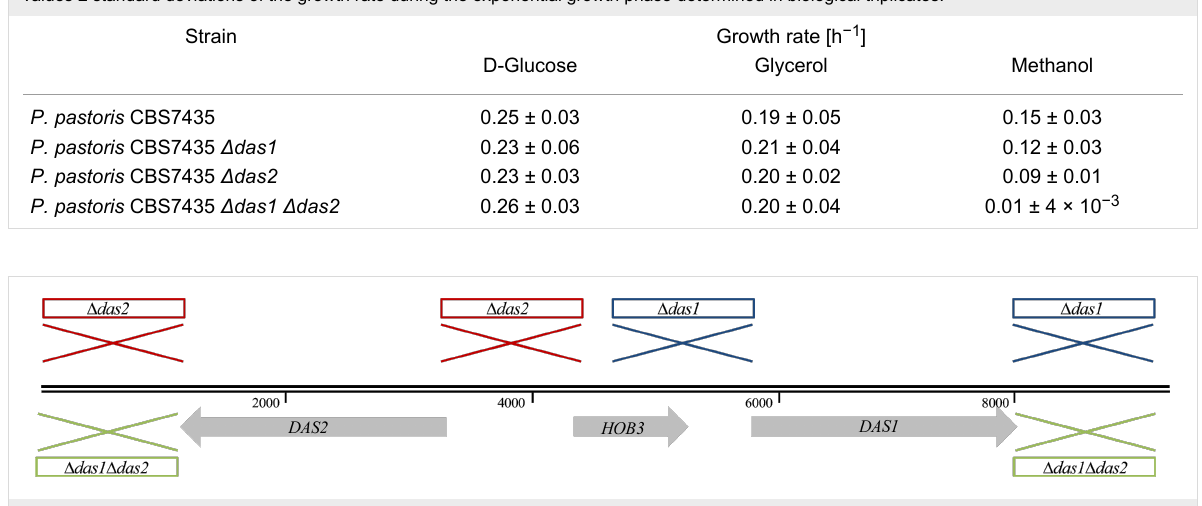
Table 1: Specific growth rates of P. pastoris CBS7435 and generated das knock-out strains on different carbon sources. Values represent mean values ± standard deviations of the growth rate during the exponential growth phase determined in biological triplicates.